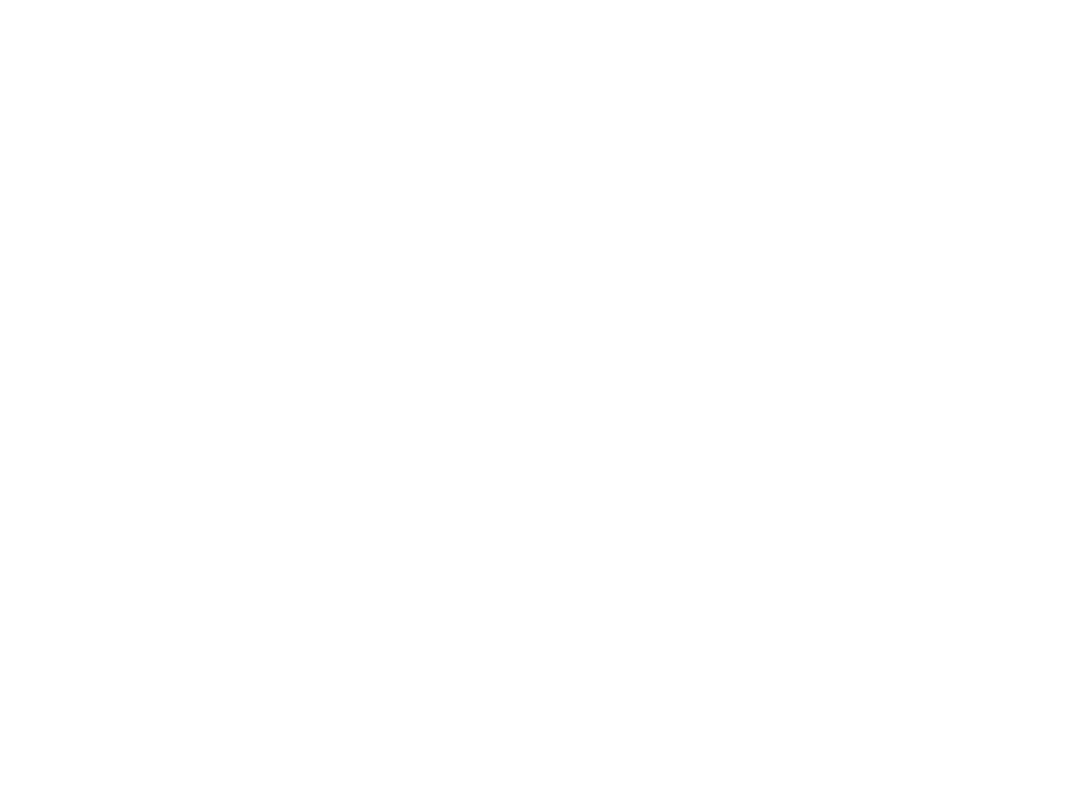
The bold is used for calculations and result